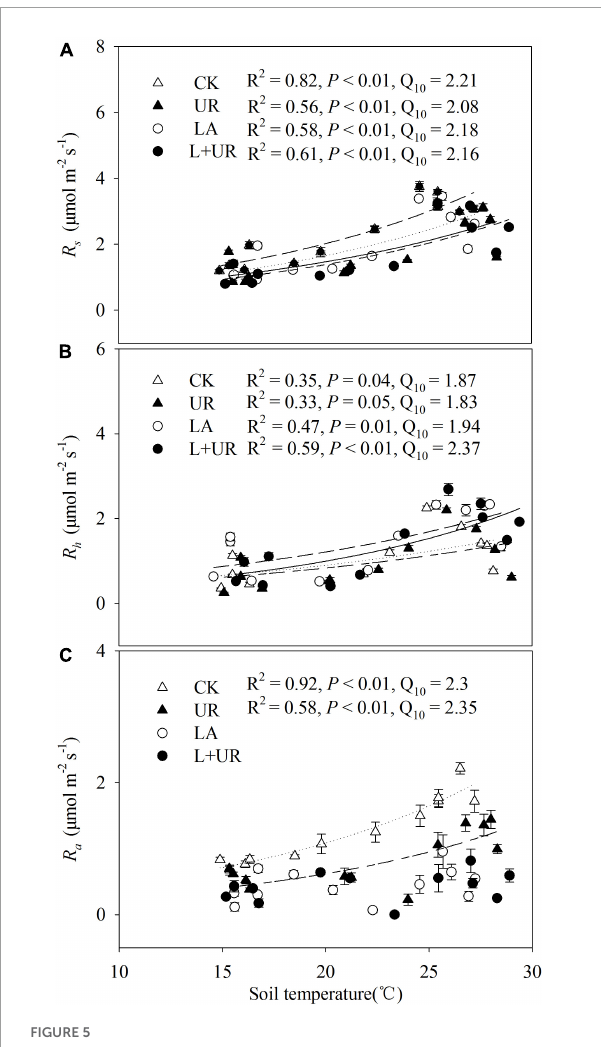
FIGURE5 (A–C) Are R s , R h , and R a in relation to soil temperature at 5 cm depth across the four treatments, respectively. CK, dotted line; UR, short-long line; LA, long-dash line; L+UR, solid